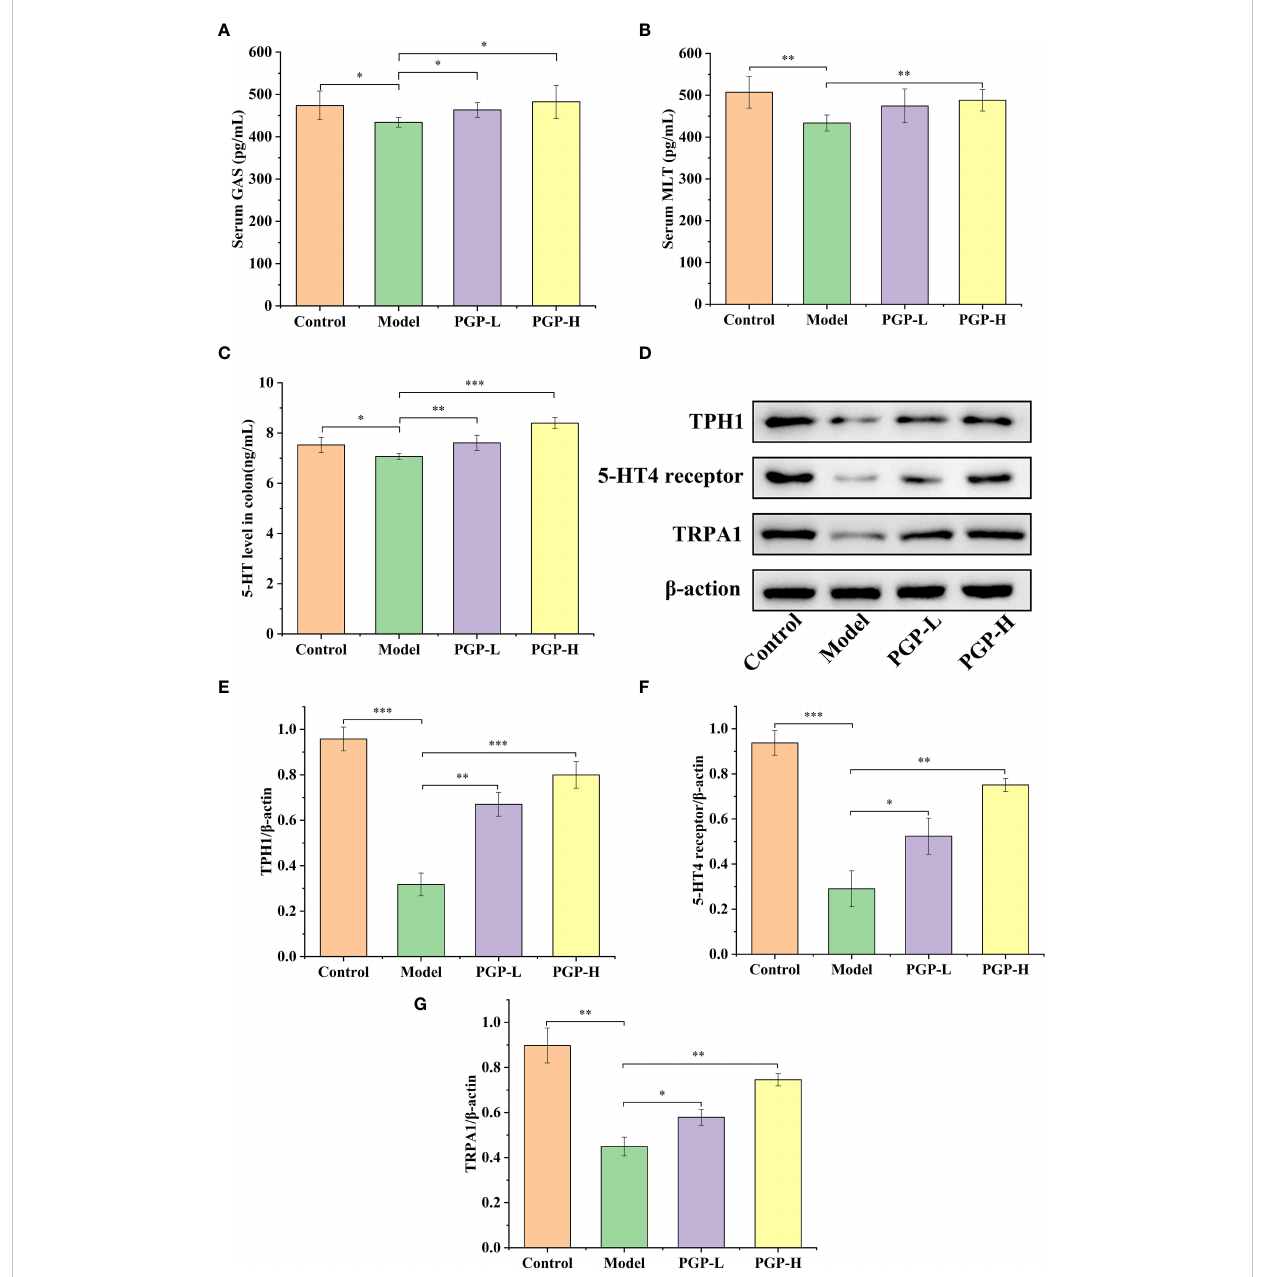
FIGURE 3 Effect of PGP on the levels of gastrointestinal hormones. (A) Gastrin (GAS) levels in serum; (B) motilin (MLT) levels in serum; (C) 5-hydroxytryptamine (5-HT) levels in the colon. (D) Expression levels of tryptophan hydroxylase 1 (TPH1), 5-HT4 reporter, and transient receptor potential ankyrin 1 (TRPA1) were detected by western blotting. Relative abundance of (E) TPH1, (F) 5-HT4 receptor, and (G) TRPA1. * p < 0.05, ** p < 0.01, *** p <